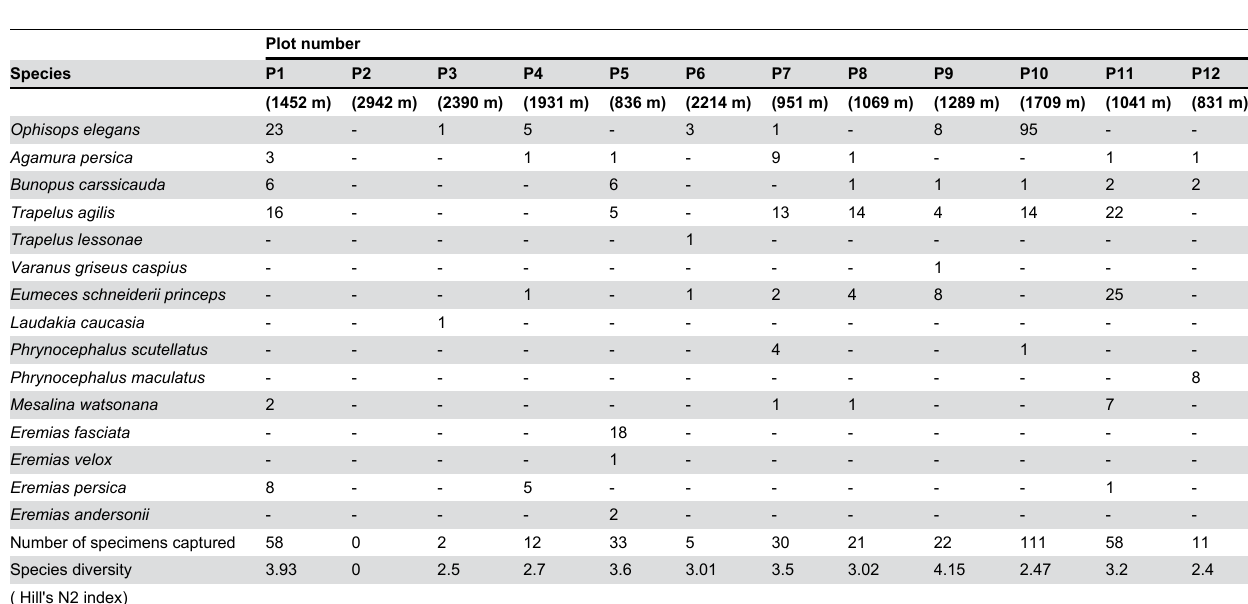
Table 1. Number of individuals of each lizard species captured in each 1-ha plot (rows) in the Qom Province of Iran, and the species diversity among 12 plots (columns).